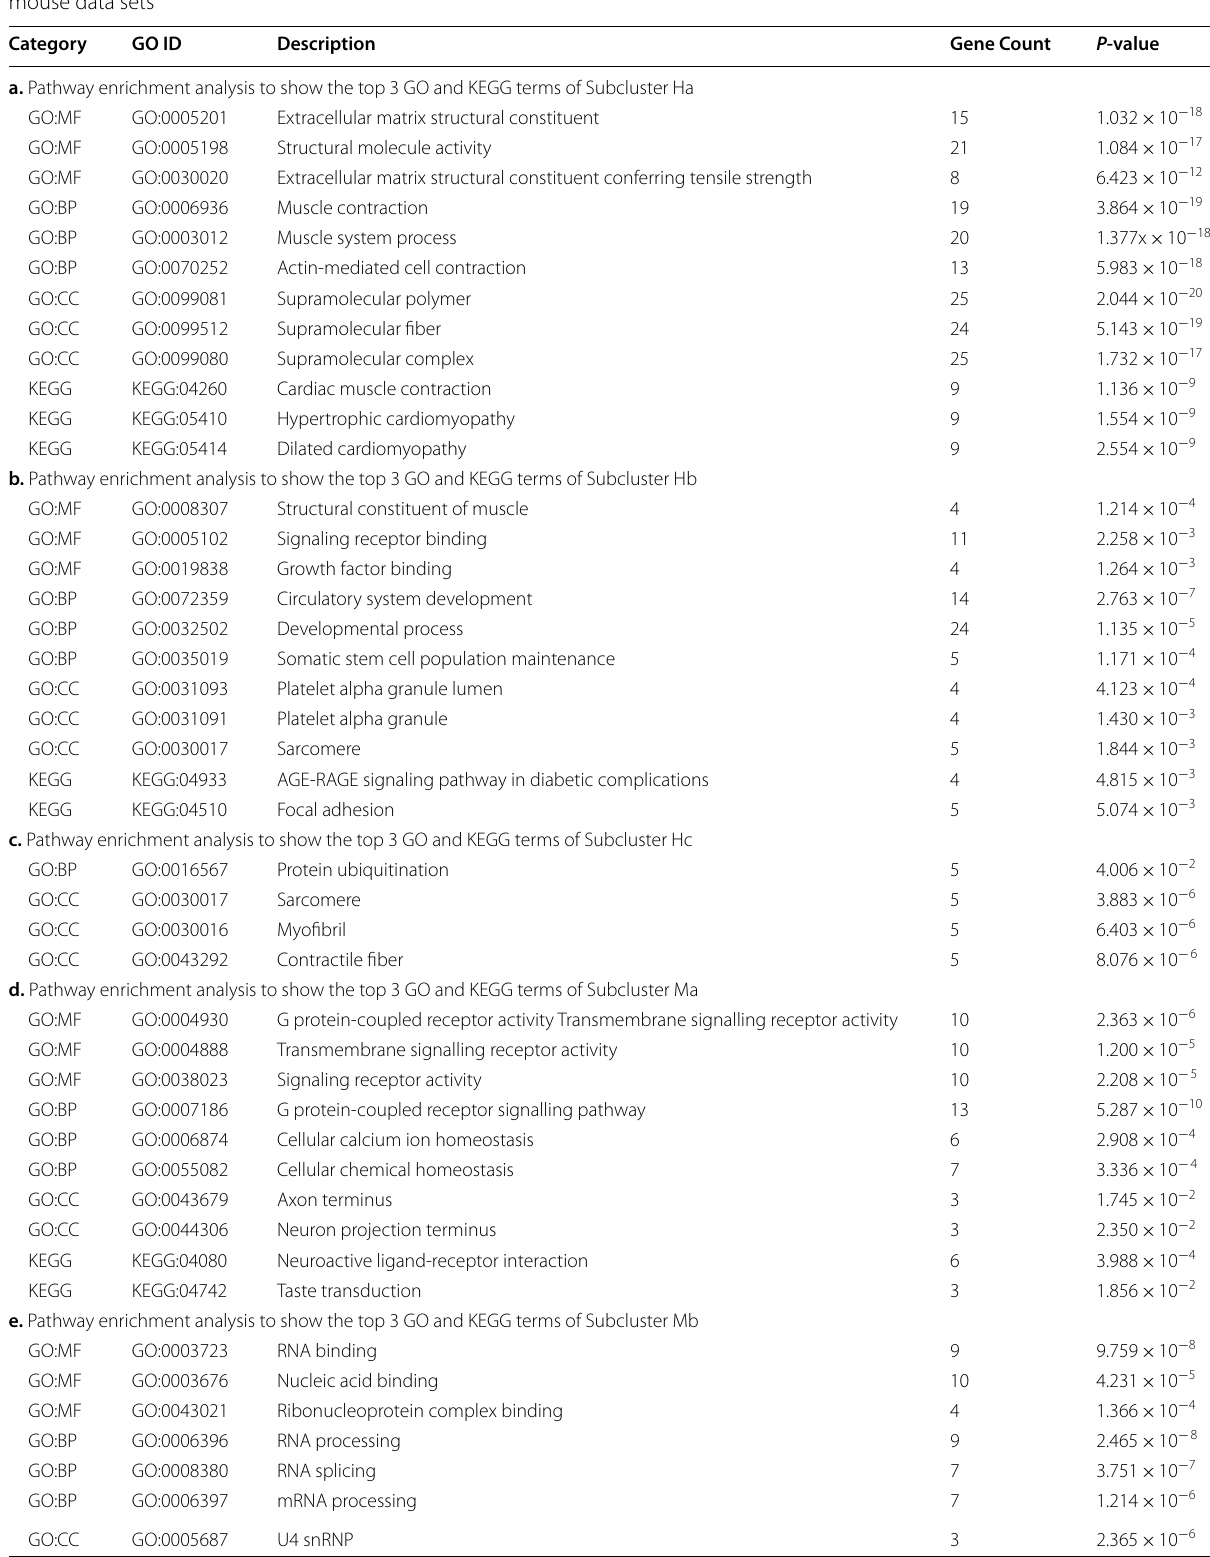
Table 5 Pathway enrichment analysis to show the significantly enriched GO and KEGG terms for each subcluster from a) human or b) mouse data